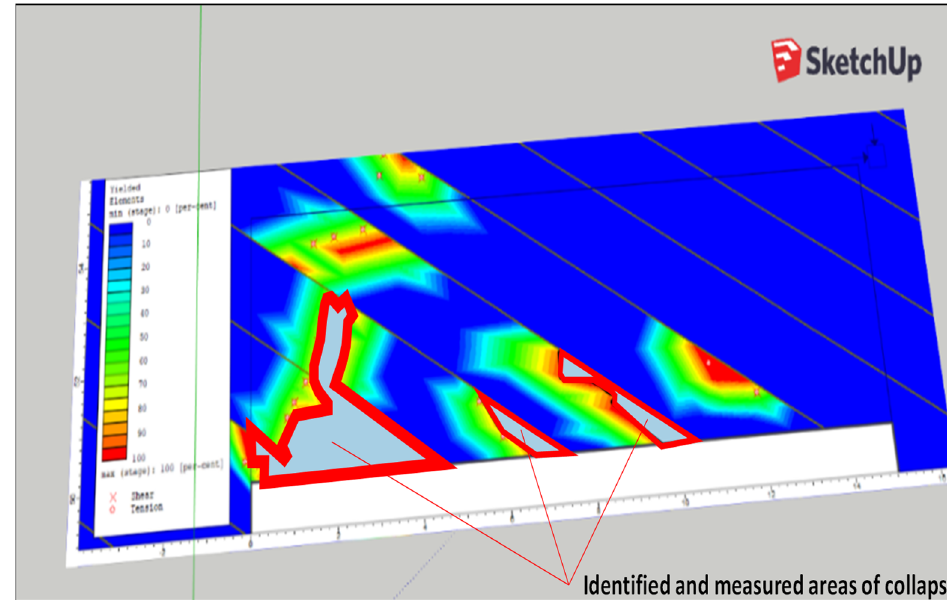
Figure 5. Overbroken zone measurement using the SketchUp software.